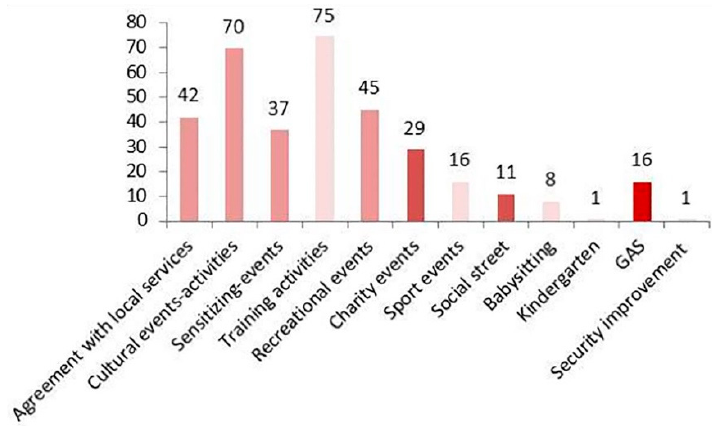
Figure 5. Activities OFFERED by the CSs. Source: [33]